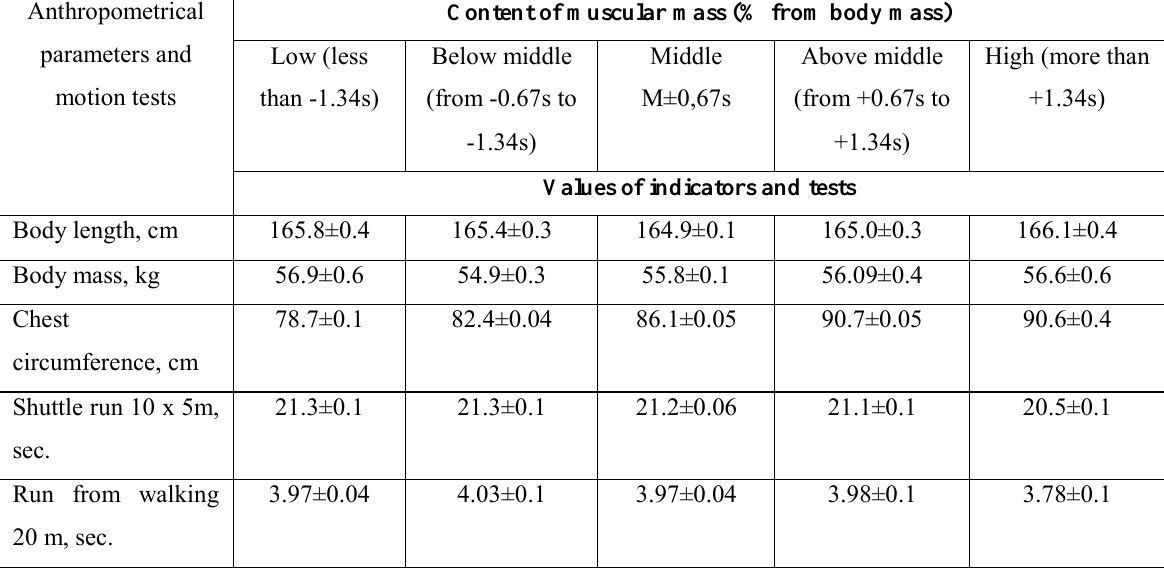
Dynamic of dependence of motion tests’ results on level of muscular mass’s expressiveness and